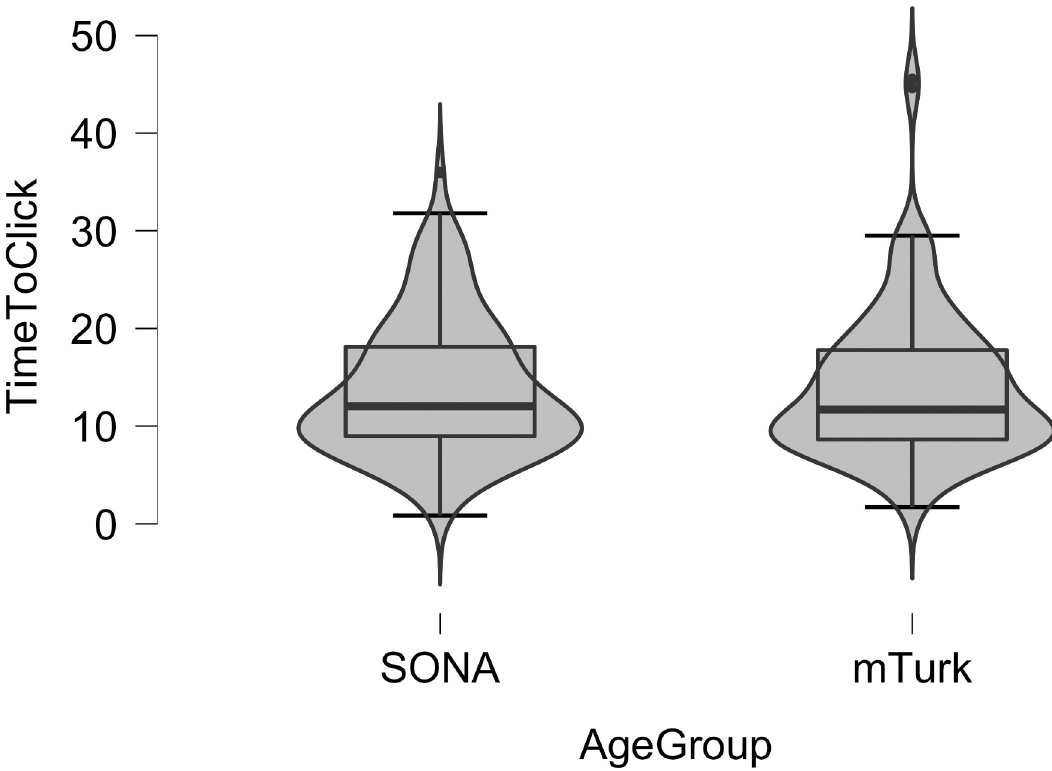
Fig 4. Violin plots with box plots superimposed of the time-to-click for the 124 younger participants (recruited via SONA) and the 106 older participants (recruited via mTurk) who indicated that they experienced the speech to song illusion. The violin plot shows the distribution of ages for time-to-click. The box plot shows the median age (the dark horizontal lines), the 75 th to the 25 th quartiles (the boxes), and the upper and lower boundaries of 1.5 � 75 th (or 25 th ) quartiles (the whiskers). Individual dots indicate